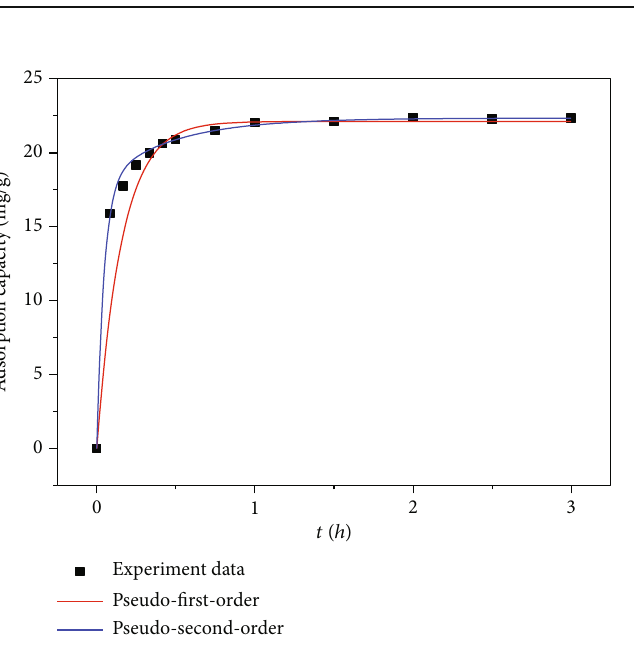
Figure 13: Adsorption kinetics for Cr (VI) removal on CSBT.